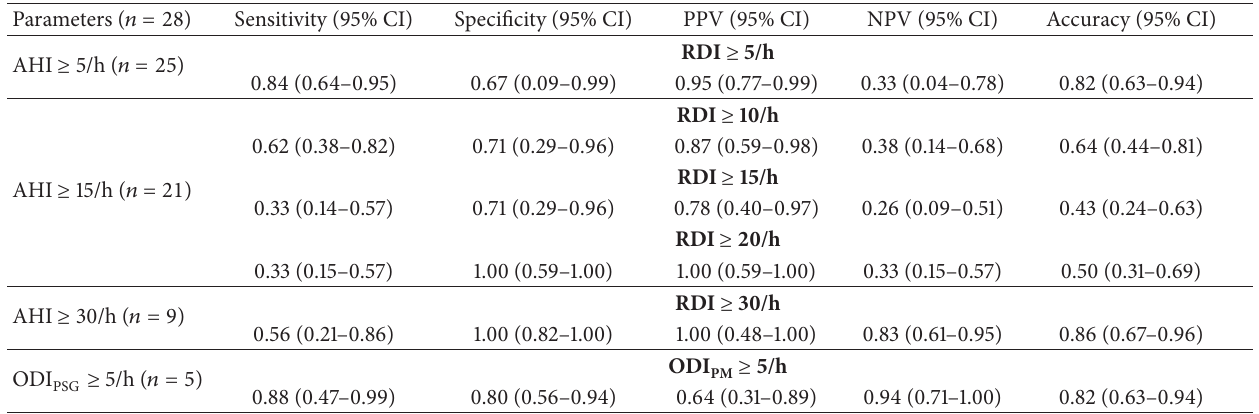
Table 5: Performance of PM for multiple AHI cut-offs and ODI.